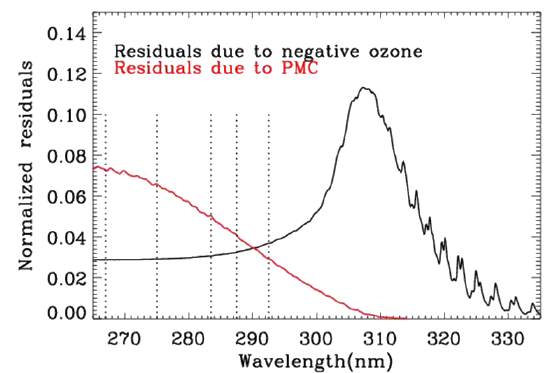
Figure 1. Radiance residuals due to the subtraction of 5% of back- ground ozone at each layer (black line) and due to PMC scattering with POD of 10 − 3 (red line), normalized to background radiance. The vertical dashed lines represent five wavelengths used in OMI PMC